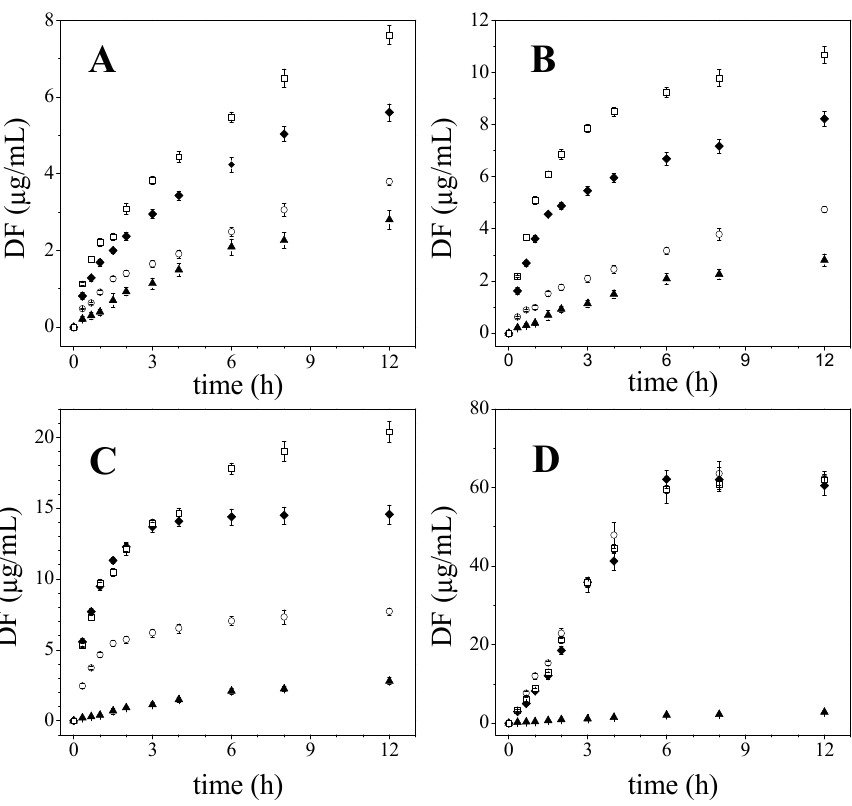
Figure 1. Diflunisal release profiles of: ( A ) DF-CS H , ( B ) DF-CS M , ( C ) DF-CS L and ( D ) DF-CMCS. In all cases: Pure diflunisal ( ▲ ), kneaded ( ○ ), physical mixture ( ♦ ) and coevaporated systems ( □ ).